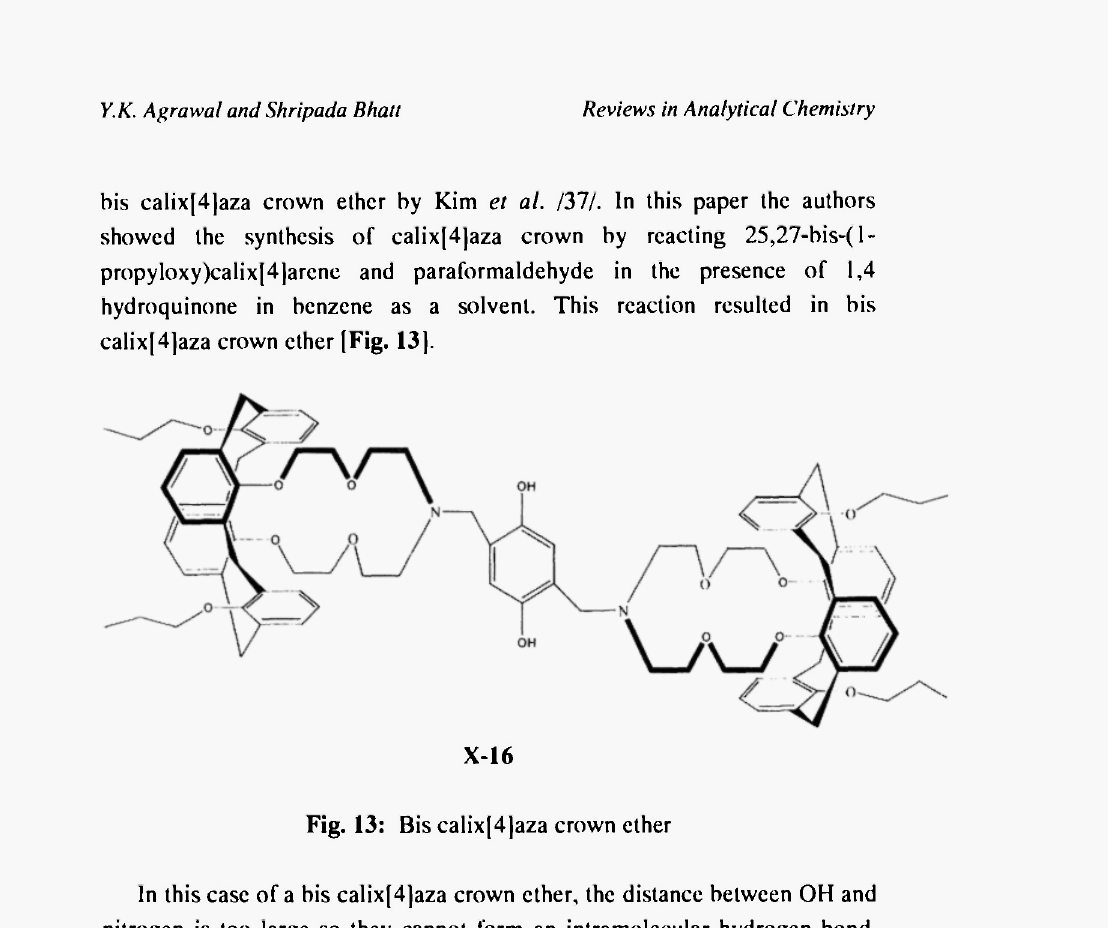
Fig. 13: Bis calix[4]aza crown